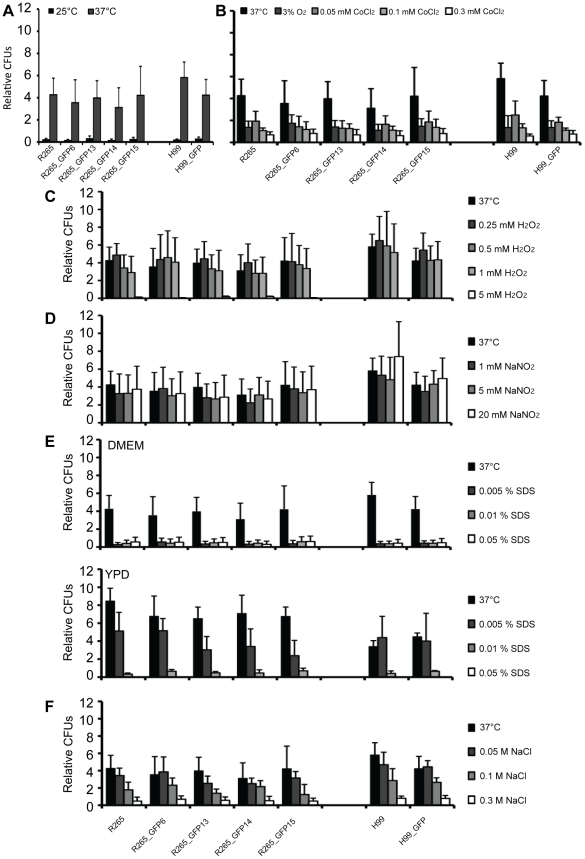
Response of GFP expressing strains to stress.The stress tolerance of the GFP-expressing isolates was tested by incubation under stress conditions for 24 hours followed by relative CFU analysis. Neither high temperature (A), hypoxia (B), oxidative stress (C), nitrosative stress (D), SDS exposure (E) or high salt (F) resulted in any significant differences in survival relative to non-GFP expressing parental strains (Table S1). Data are presented as means of at least three independent repeats with 2 times standard error.